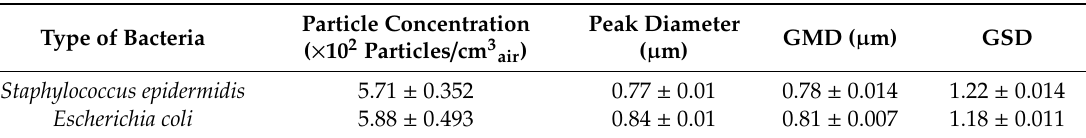
Figure 5. ( a ) The particle size distributions of generated Staphylococcus epidermidis and Escherichia coli aerosols. ( b ) Filtration efficiencies of the filters with various weights of deposited NSS particles against bioaerosols. ( c ) Bactericidal performance of the filters with various weights of deposited NSS particles against captured bioaerosols. Error bars indicate standard deviations ( n = 3). Table 1. Concentration, peak diameter, geometric mean diameter (GMD), and geometric standard deviation (GSD) of test bacterial bioaerosols ( n = 3).